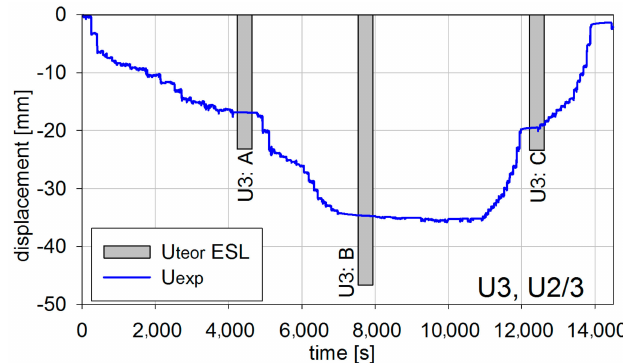
Figure 18. Vertical displacements in U2 / 3 for the U3 test.